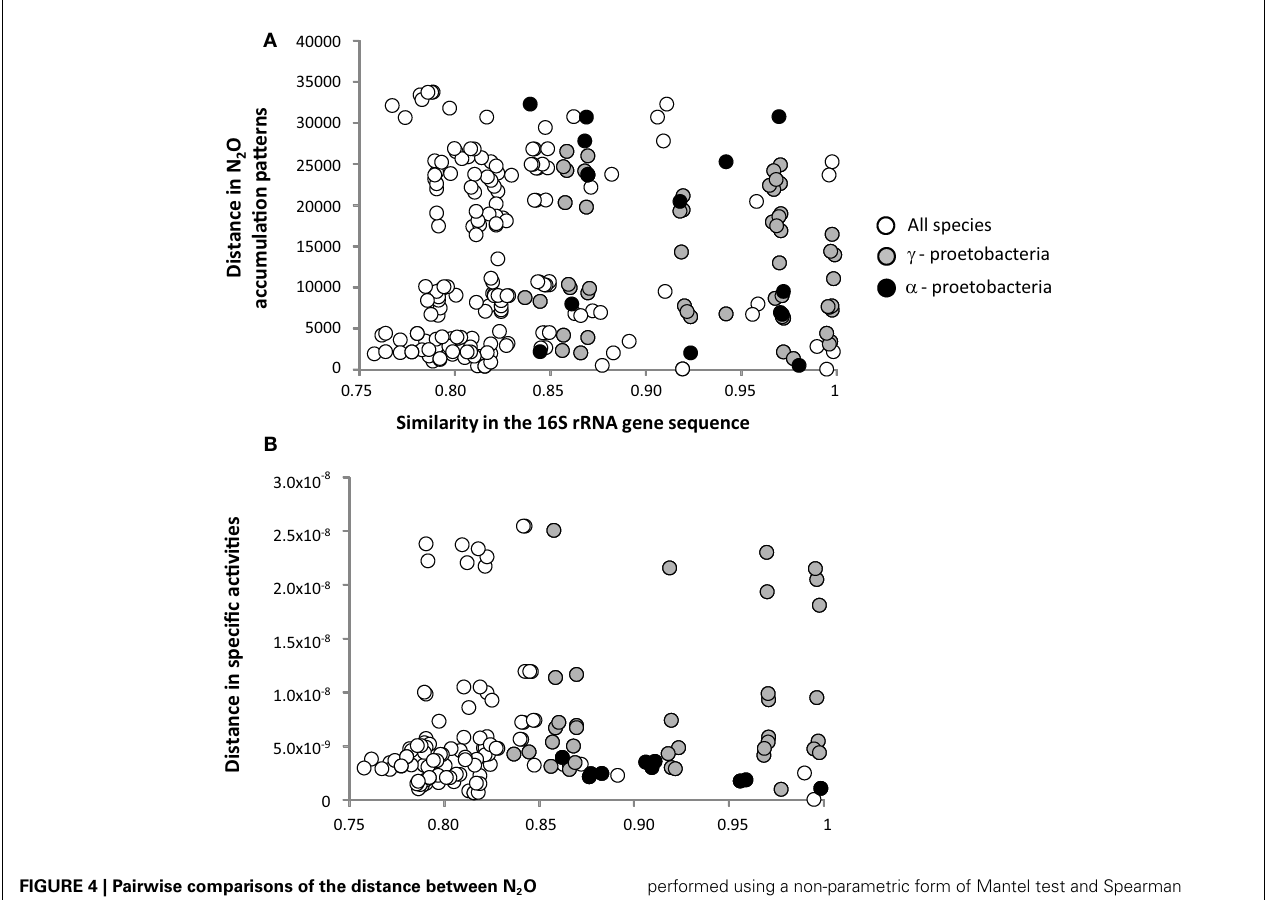
performed using a non-parametric form of Mantel test and Spearman coefficient ( ρ ). Significance level was checked using a permutation test (5000 permutations). Linear regression lines are also indicated on the graph with associated r 2 values. All correlations were non-significant (see Table 2 for P